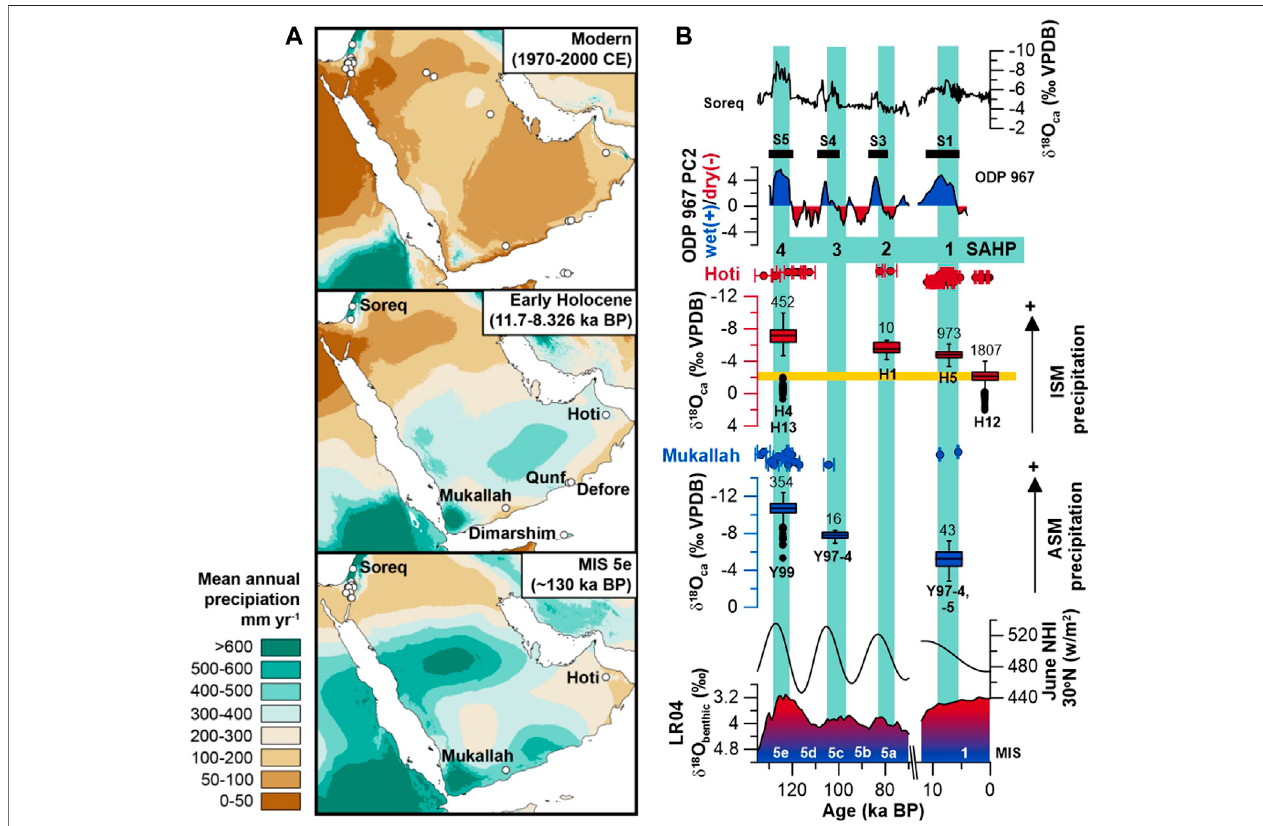
FIGURE 1| (A) simulated mean annual precipitation maps of the Arabian Peninsula for modern (Fick and Hijmans, 2017), Early Holocene (Fick and Hijmans, 2017; Fordham et al., 2017; Brown et al., 2018) and MIS 5e (Otto-Bliesner, 2006; World Clim, 2015) periods. Speleothem cave sites (white circles) show distribution of fossil stalagmites (modern) and their respective growth periods (Early Holocene and MIS 5e). (B) box-whisker plots of stalagmite δ 18 O ca values from Hoti (red) and Mukallah (blue) caves vs. the Soreq Cave δ 18 O ca curve (Bar-Matthews et al., 2003; Grant et al., 2012; Grant et al., 2016), ODP 967 PC2 wet/dry index and sapropel layers (Grantet al.,2017),low-latitude(30 ° N;BergerandLoutre,1991)andglobalice-volume( δ 18 O benthic ;Lisieckiand Raymo,2005).Blackcirclesdenotestatistically extreme values. Sample counts and stalagmite specimens are given above and below boxes, respectively. See Supplementary Material for results of ANOVA and Wilcoxon rank sumtest. Theyellow bar denotestherange ofmodernstalagmite δ 18 O ca valuesfromHoti Cave(Fleitmannet al.,2003a;Fleitmannetal., 2011). 230 Thages andage uncertainties (2 σ ) for Mukallah (blue) and Hoti (red) cave speleothems are given above their respective boxplots (Fleitmann et al., 2011; Nicholson et al., 2020). Relevant Marine Isotope Stages are provided using the taxonomy of Railsback et al.